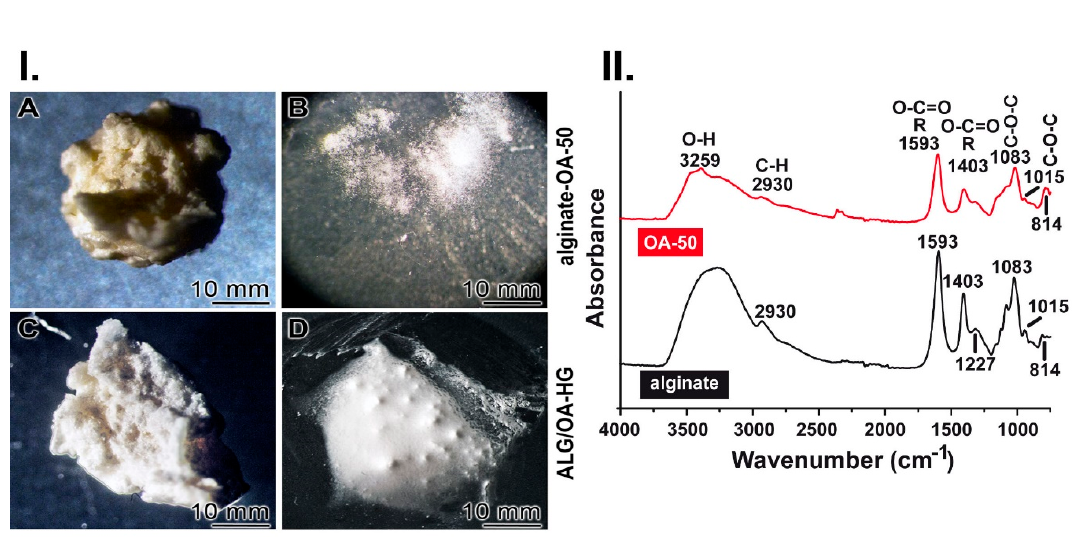
Figure 3. “ALG/OA-HG” and the characterization. ( I. ) Ionic cross-linking within the “ALG/OA-HG”. ( A ) Dry alginate-OA-50 material. ( B ) After submersion in saline the hybrid material dissolves almost completely after 12 h. ( C ) Solid alginate-OA-50 material obtained after treatment with ZnCl 2 and drying. ( D ) After exposure to saline the material stays stable. ( II. ) Characterization of alginate and oxidized alginate (OA-50) by FTIR. Alginate shows the characteristic carboxylate (COO − ) vibrational mode signals at 1593 cm − 1 and 1403 cm − 1 . Then C-O-C stretching signals of the acetal group are recorded at 1083 cm − 1 and at 1015 cm − 1 . The comparative FTIR spectrum to OA-50 shows that the signals for the latter material are less intensive.